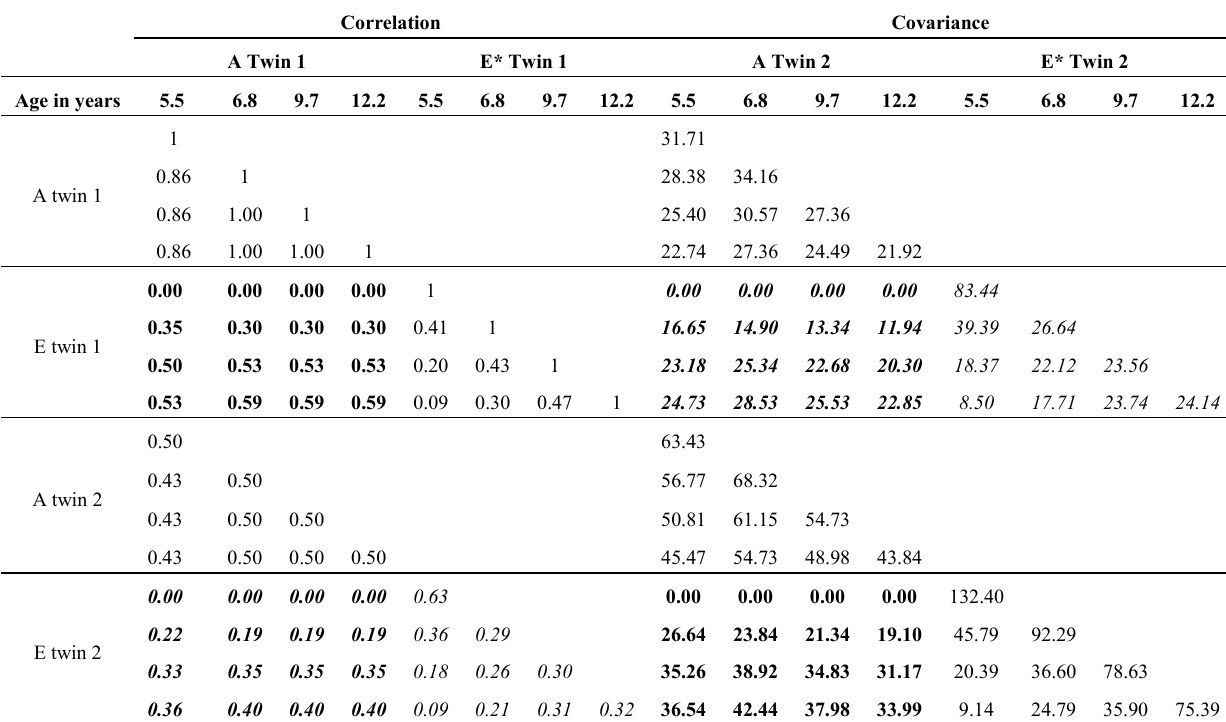
Table 4. MZ covariance matrix of A and E* in the AE* model of FSIQ with Ph->E transmission. These include the AE* covariance and AE* correlation within twins (bold) and between twins (bold italics) and the covariance and correlations among the twin environments (italics). Age is given in years.